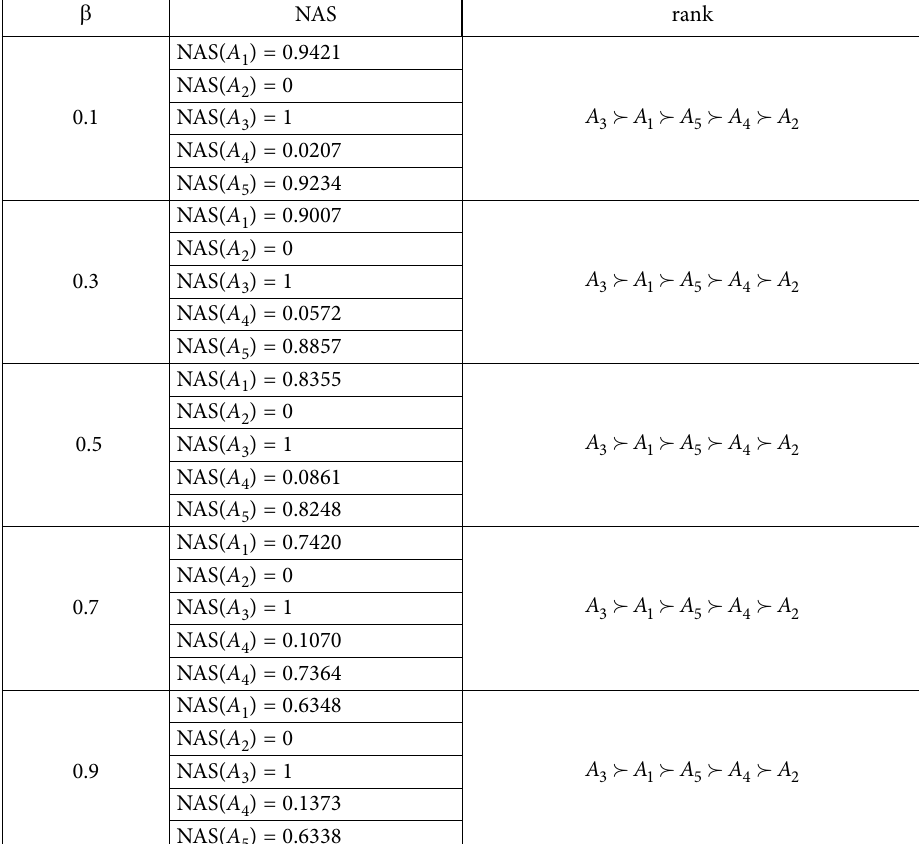
Table 21. the rank results of different values of